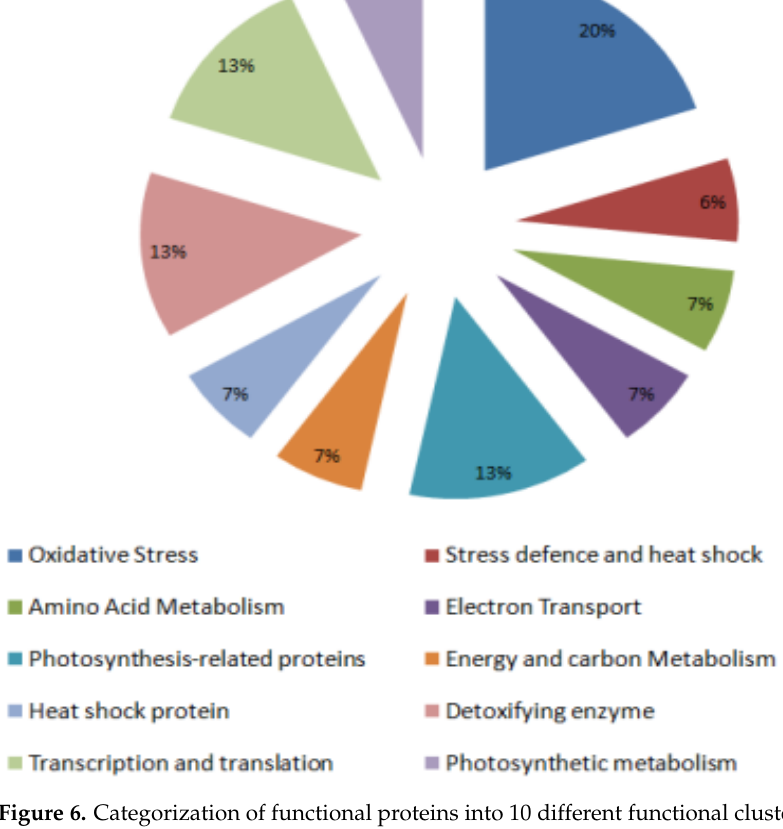
Figure 6. Categorization of functional proteins into 10 different functional clusters.